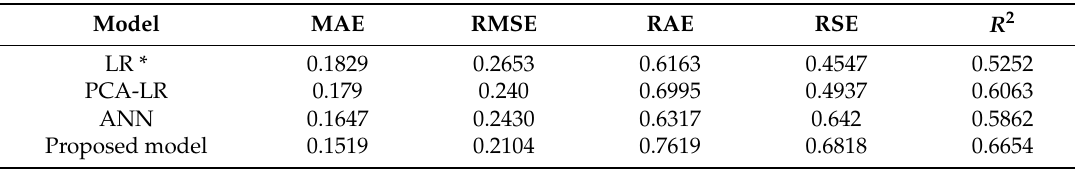
Table 10. Performance indicators for MEI prediction